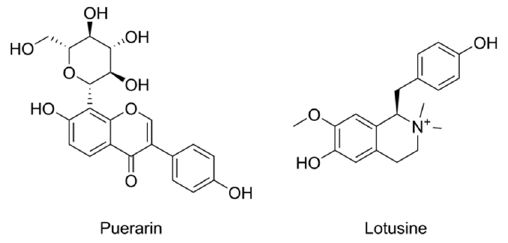
Figure 1. Chemical Structures of puerarin and lotusine.